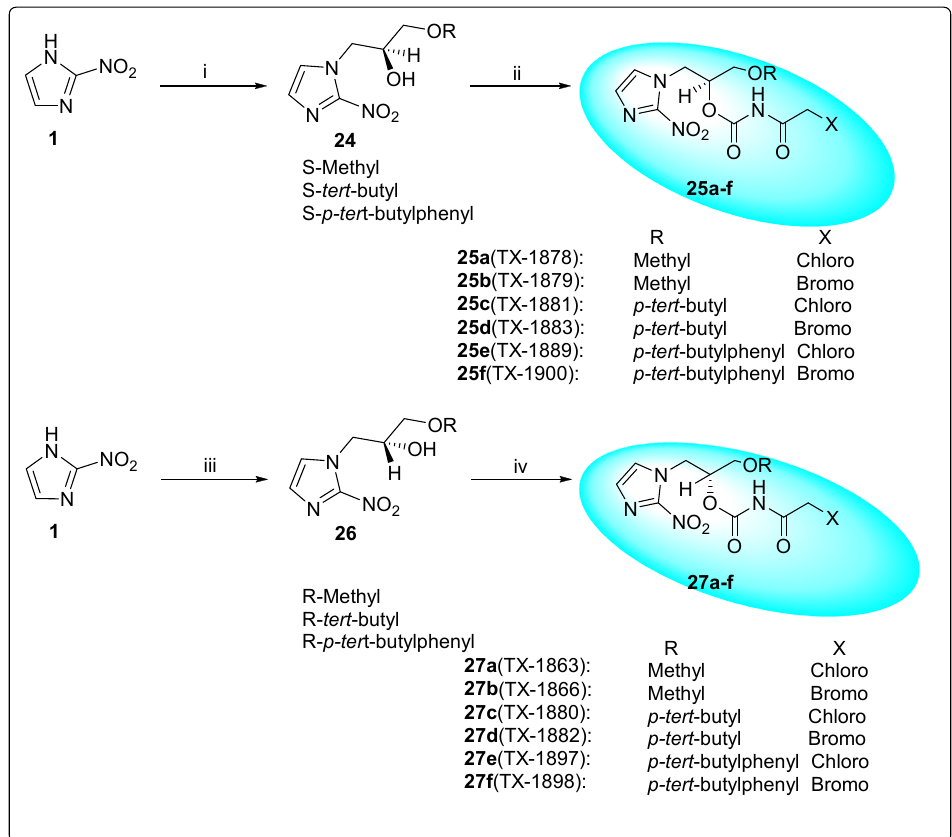
Table 1. Inhibition data of dual-function Misonidazole